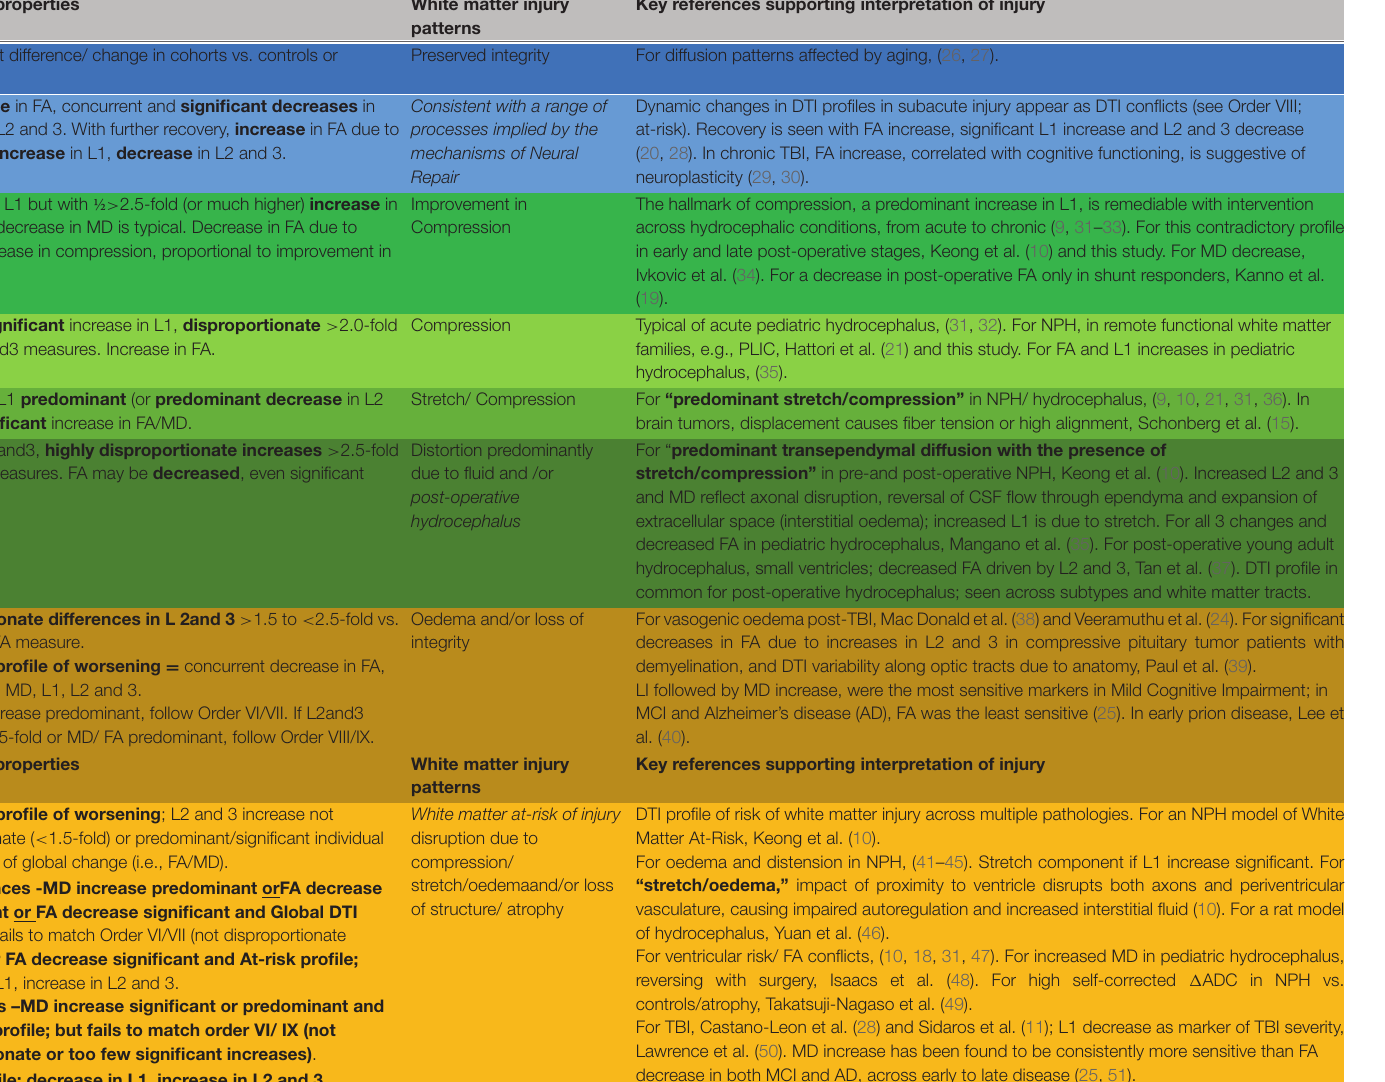
TABLE 4 | Recurring common properties of DTI profiles, arranged by expected order of white matter reversibility. Order Occurrence DTI profile